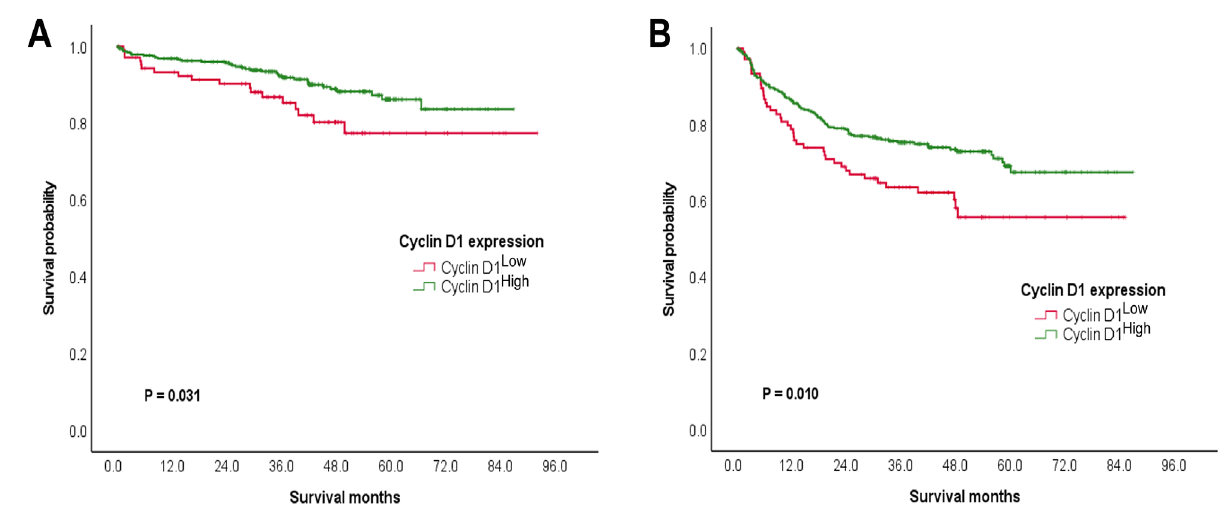
Figure 2. Prognostic stratification of cyclin D1 expression. Favorable prognostic potential of cyclin D1 High to predict ( A ) OS and ( B ) RFS.